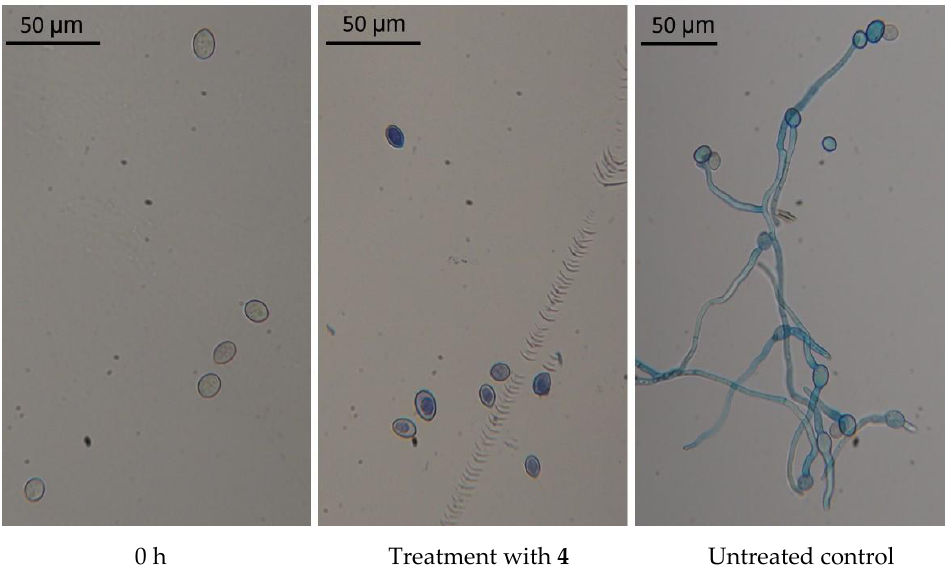
Figure 2. Evan’s blue staining of B. cinerea . Conidia of B. cinerea were stained at 0 h and after 24 h from treatment with 4 at 15 µM. Untreated conidia (control) were stained after 24 h. Conidial suspensions treated with 4 at 15 µM were rinsed with distilled water and plated on potato dextrose agar (PDA). No fungal growth was observed, revealing the fungicidal activity of the peptide at that concentration.